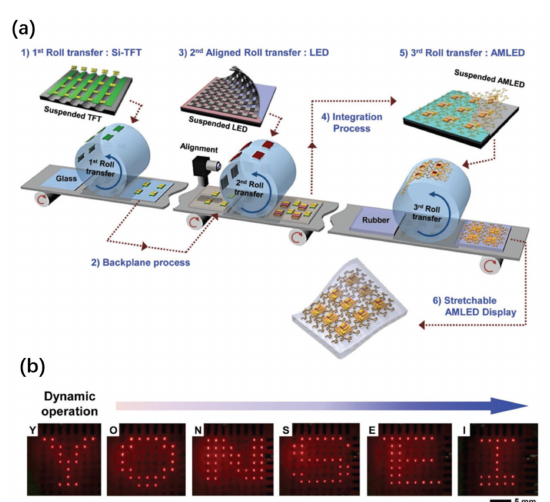
Figure 22. ( a ) A general roll-to-roll transfer printing process for making flexible active matrix LED (AMLED) devices integrated onto the thin-film-transistors (TFTs). ( b ) Emission images of the flexible micro-LED arrays assembled by roll-to-roll printing. Adapted with permission from [100]. Copyright John Wiley and Sons,